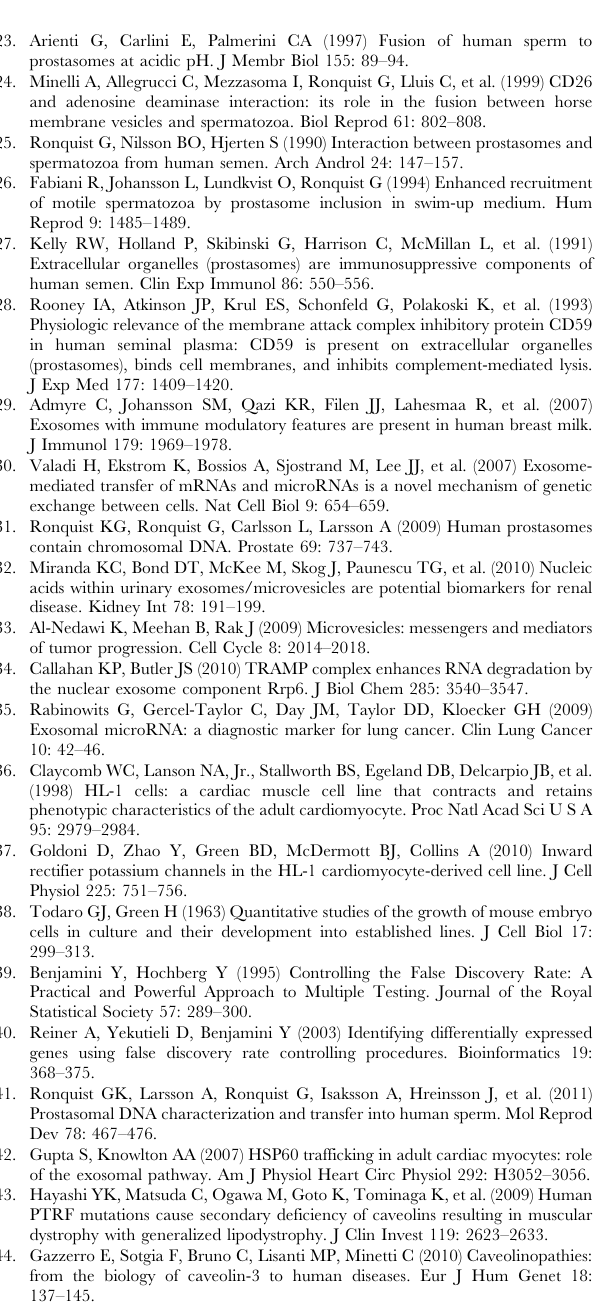
Table S3 Differentially expressed genes in Fb after exosome incubation. Fibroblasts were transfected with micro- vesicles/exosomes and a clearcut effect on gene expression was found. After ultracentrifugation the microvesicle/exosome-en- riched pellet resuspended in fresh DMEM that induced about 70% more changes (65 up and 96 down), here listed, than the microvesicle/exosome-deficient supernatant that induced only 96 changes (21 up, 75 down) when incubated with the fibroblast for 48 h.